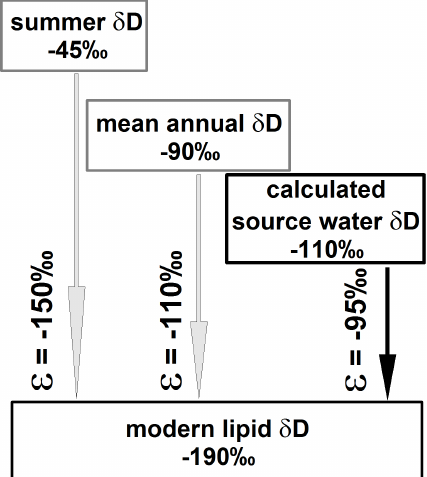
Figure 3. Calculated isotopic fractionation factors ( ε) between sum- mer and mean annual precipitation and modern lipids, as well as calculated source water δD based on published fractionation factors in arid ecosystems (ca. − 95‰, according to Feakins and Sessions, 2010; Günther et al.,